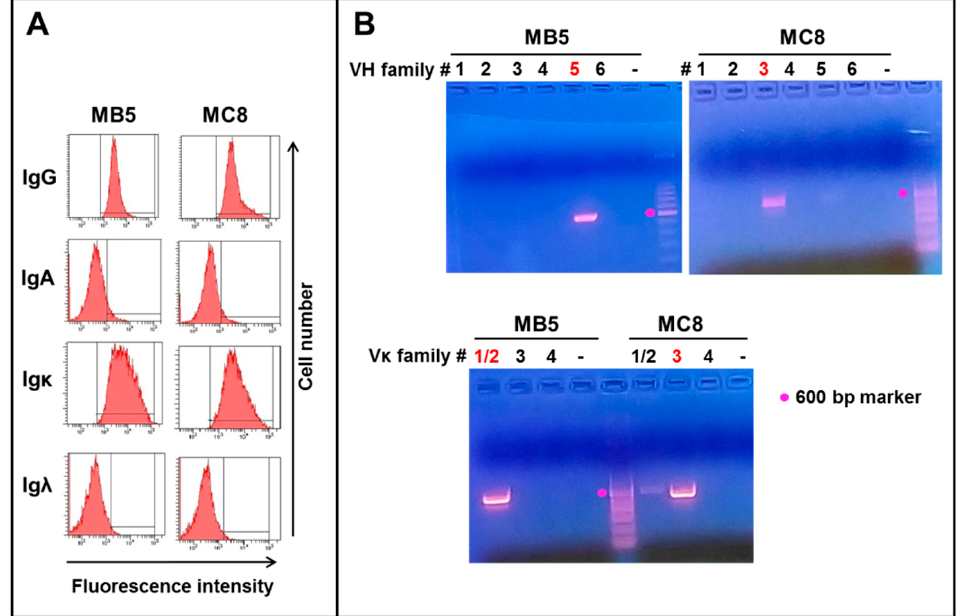
Figure 3. Identification of IgG isotypes and VH and Vk families for the MB5 and MC8 clones. ( A ) The IgGk isotypes of the 2 clones were identified by flow cytometry. ( B ) RNA from each clone was amplified by PCR using forward primers specific for the different families of heavy chain leader sequences (VH1 to VH6 families, upper panels) or κ light chain leader sequences (V κ 1/2, V κ 3 or V κ 4 families, lower panel) and common reverse primers. The numbers above each lane identify the VH or Vk family numbers that were probed with specific primer sets. The VH or Vk families that resulted in positive PCR bands are shown in red.